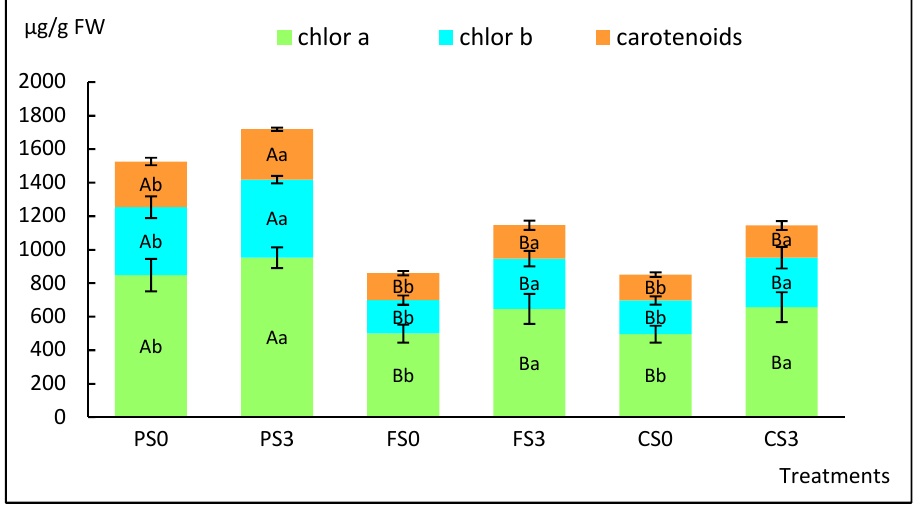
Figure 9. Photosynthetic pigments of willow plantlets cultured for 4 weeks in the phytotron and 6 weeks in the greenhouse in three types of soil. PS0, PS3: plants grown in peat and micropropagated without sucrose (PS0) or with 3% sucrose (PS3); FS0, FS3: plants grown in a forest soil and micropropagated without sucrose (FS0) or with 3% sucrose (FS3); CS0, CS3: plants grown in a crop soil and micropropagated without sucrose (CS0) or with 3% sucrose (CS3). Values are presented as means ± standard error of 12 leaves per treatment. For each variable, different uppercase letters indicate significant differences in relation to the soil, and different lowercase letters indicate significant differences relative to the sucrose supplementation ( p < 0.05). formed in leaves of plantlets that had been cultured with S3 and had been planted in peat, whereas in forest and crop soil, similar values were obtained (Figure 9, Table